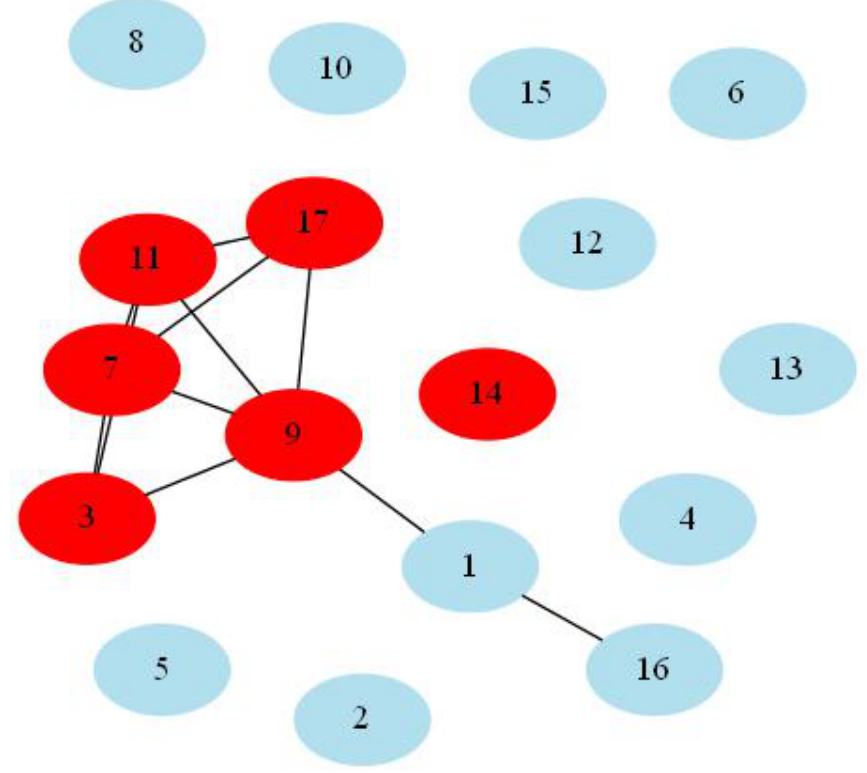
Figure 7: As Figs. 5 & 6, with the Canberra